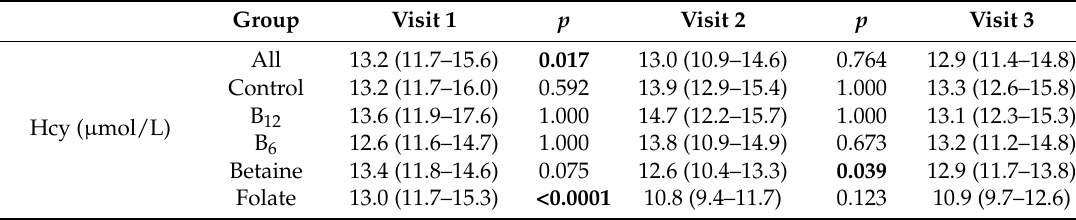
Table 3. Hcy and substances involved in its metabolism. Visit 1, after 1 month of alcohol abstinence; visit 2, after 1 month of white wine consumption; visit 3, after next month after visit 2 (2nd alcohol abstinence). PLP,